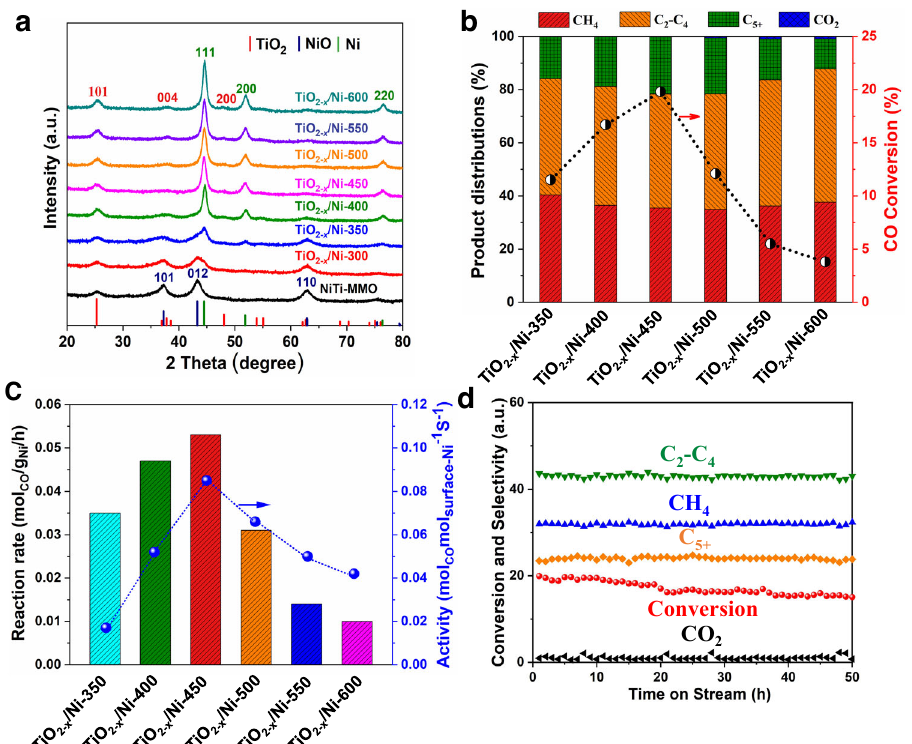
Fig.1|StructuralpropertiesandcatalyticperformanceofTiO 2 − x /Nicatalystsin syngas conversionunder different conditions.a XRDpatterns of NiTi-MMO and a series of TiO 2 − x /Ni catalysts reduced at different temperatures. b The conversion andproductdistributionaswellas( c )reactionrateandactivityovervariousTiO 2 − x /